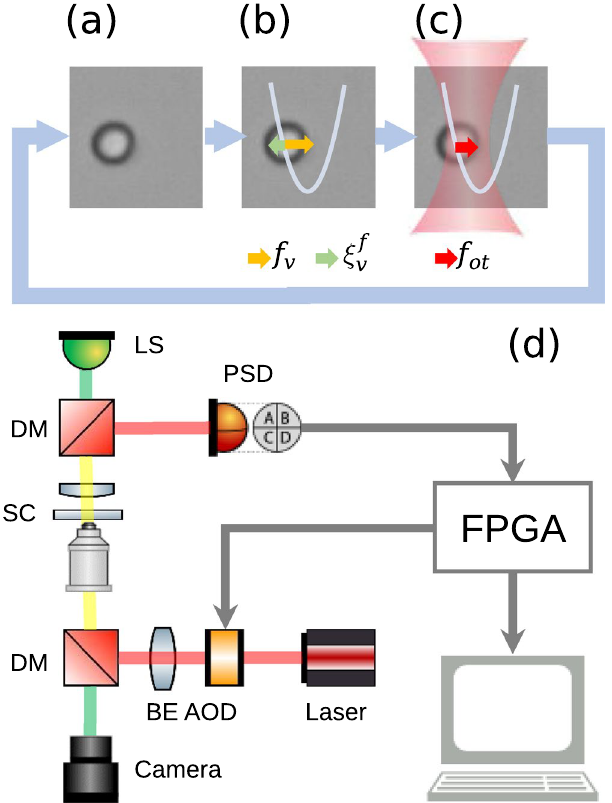
Figure 1. ( a )–( c ) The feedback protocol for generating the VP and VT. ( a ) Identify the particle position using ξ f the PSD. ( b ) Compute the force, f v v , required to generate the effects of the assigned VP and VT. ( c ) Deflect + ξ f f v the laser center by the AOD to apply the same amount of force, f ot v , on the particle. ( d ) A schematic = + drawing of the OFT. DM: dichroic mirror, PSD: position sensitive device, AOD: acousto-optic deflector,